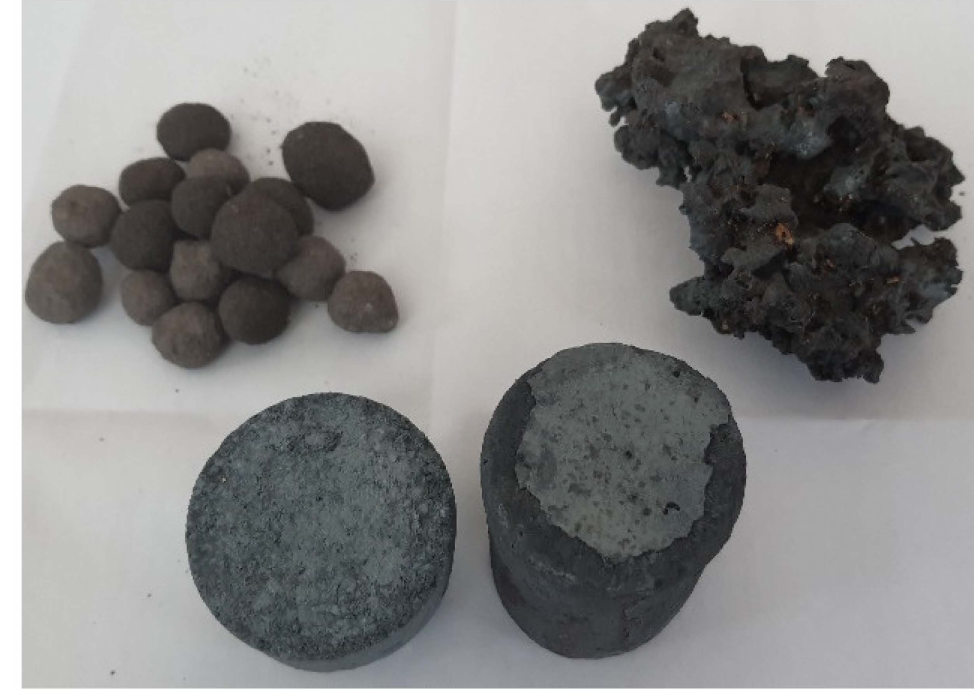
Figure 1. By-products made from waste with high iron content